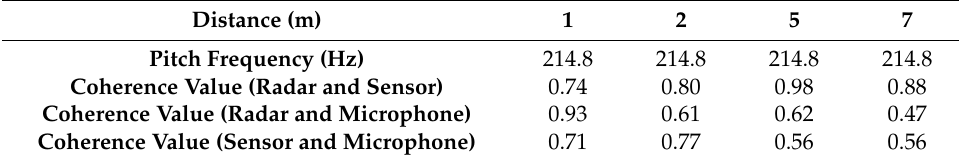
Table 1. Results of coherence between the radar and microphone, radar system and vibration sensor, and between the microphone and vibration sensor for the spoken English vowel /a/, when the distance between the radar system and the subject is 1 m, 2 m, 5 m and 7 m, respectively.